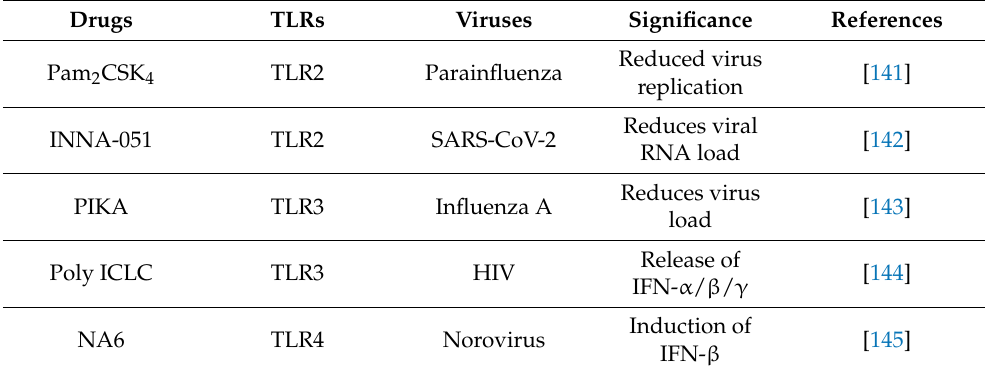
Table 4. Reported antiviral agonists employing Toll-like receptors